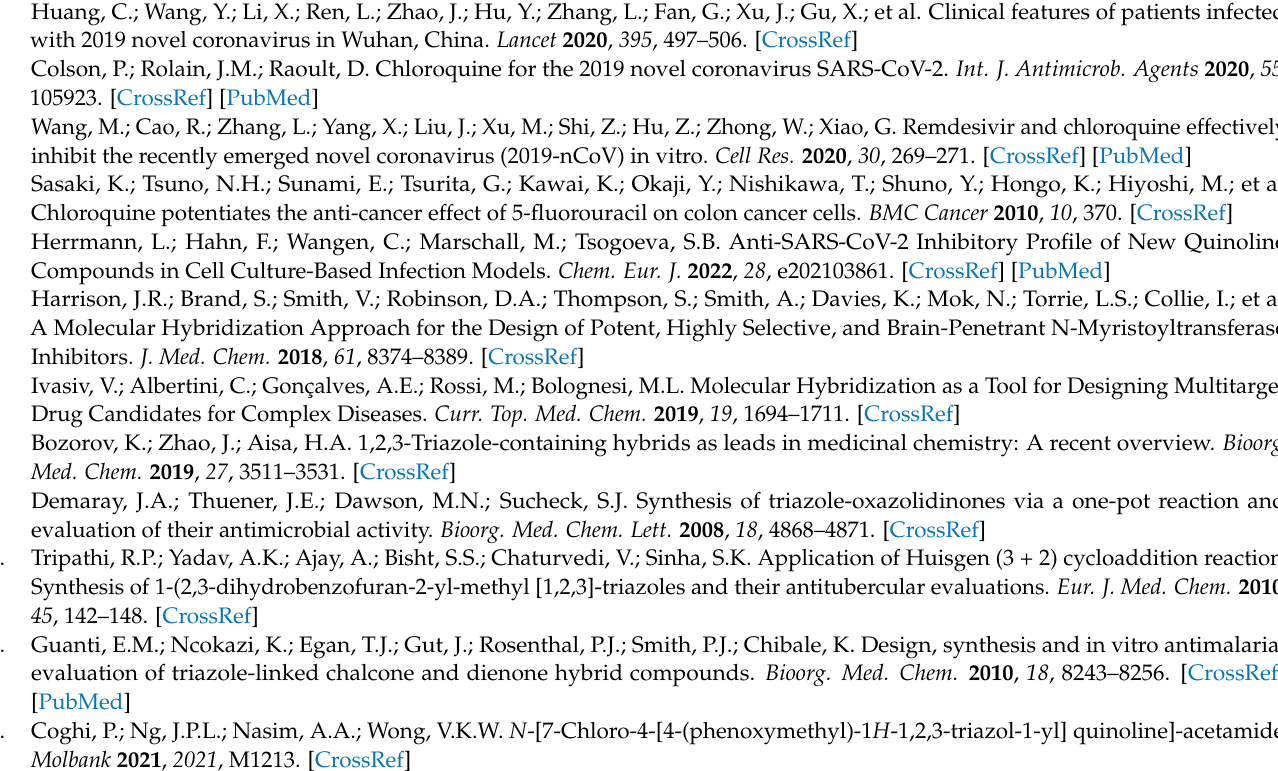
Figure S2: 13 C-NMR compound 4 , Figure S3: 1 H-NMR compound 5 , Figure S4: 13 C-NMR compound 5 , Figures S5 and S6: HSQC compound 5 , Figure S7: UV spectrum; Figure S8: HRMS of 4 and 5 , Figure S9: cytotoxicity results, Table S1: 1 H and 13 C-nuclear magnetic spectroscopy (NMR) chemical shifts, Table S2: Physicochemical properties of 5 calculated by SwissADME, Figure S10: BOILED-Egg graph, Figure S11: Biolayer interferometry of compound 5 . References [18,22,23] are cited in the supplementary